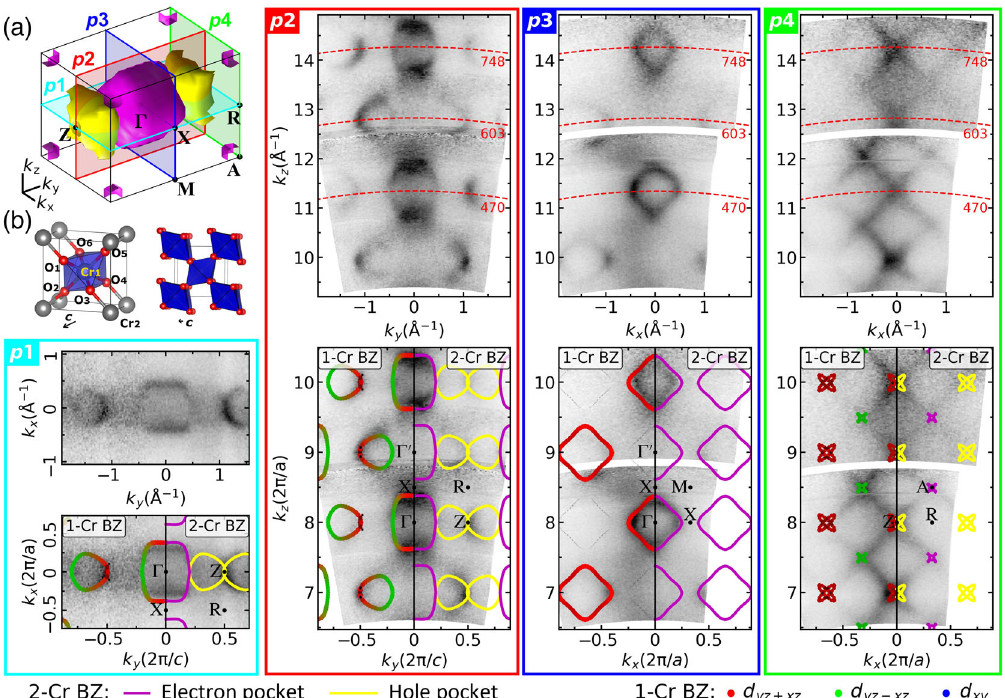
¼ 0 . 4 eV) calculations; (b) unit cell of CrO 1 - p 4 , maps at FIG. 1. Experimental and theoretical FS of CrO 2 : (a) GGA þ U (U 2 ; ( p eff top) experimental ARPES maps of the FS along the planes marked at (a); ( p 1 - p 4 , maps at bottom) the same data overlaid with the ¼ 0 . 4 eV) results on the right ( k > 0 ) side. The apparent doubling of the FS periodicity in k space is due to the GGA þ U ( U x;y eff < 0 ) nonsymmorphic space group of CrO 2 . This is confirmed by unfolding of the calculated FS onto the 1-Cr cell shown on the left ( k x;y side. These ARPES data were collected with p -polarized light at photon energy of 470 eV for p 1 and varied in the 320 – 820 eV range for ( p 2 - p 4 ) as indicated in the top